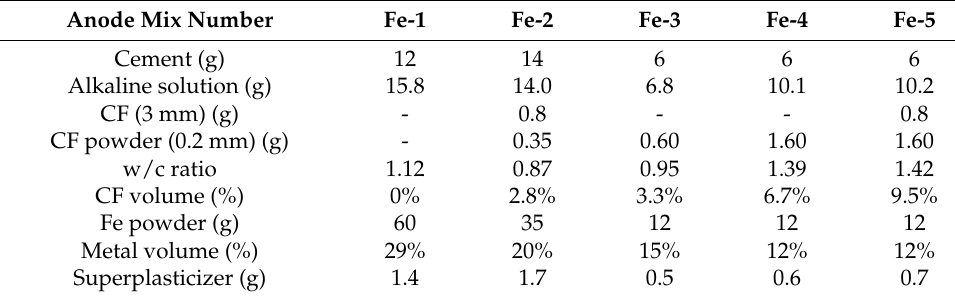
Table 7. Mix proportions of the “powder-mixing” anodes.